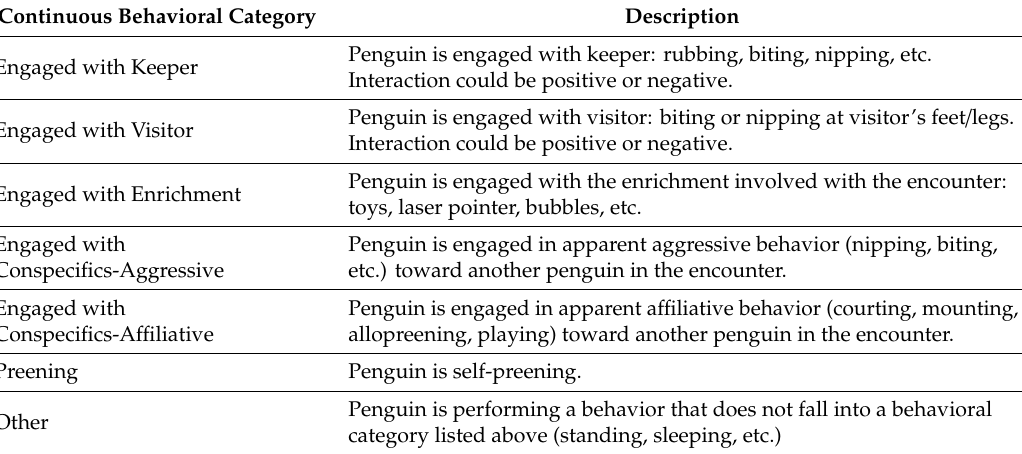
Figure 2. Study design, represented as a timeline for behavioral data collection. Mornings or afternoons when encounters occurred are represented by black boxes; mornings or afternoons when encounters were cancelled are represented by grey boxes. Pre-encounter and matched control pre-encounter data were collected from 09:00–10:00 and / or 14:00–15:00. Post-encounter and matched-control post-encounter data were collected from 11:00–12:00 and / or 16:00–17:00. Table 2. Ethogram for data collection on penguins participating in